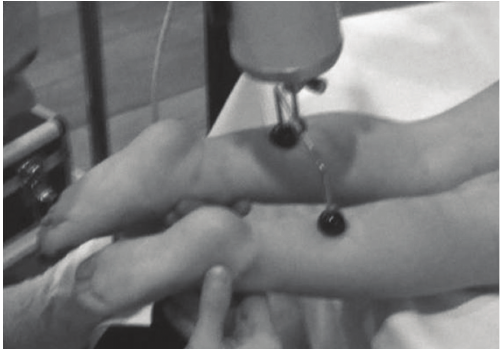
Figure 1: Picture representing the child during the treatment and the site of intervention.